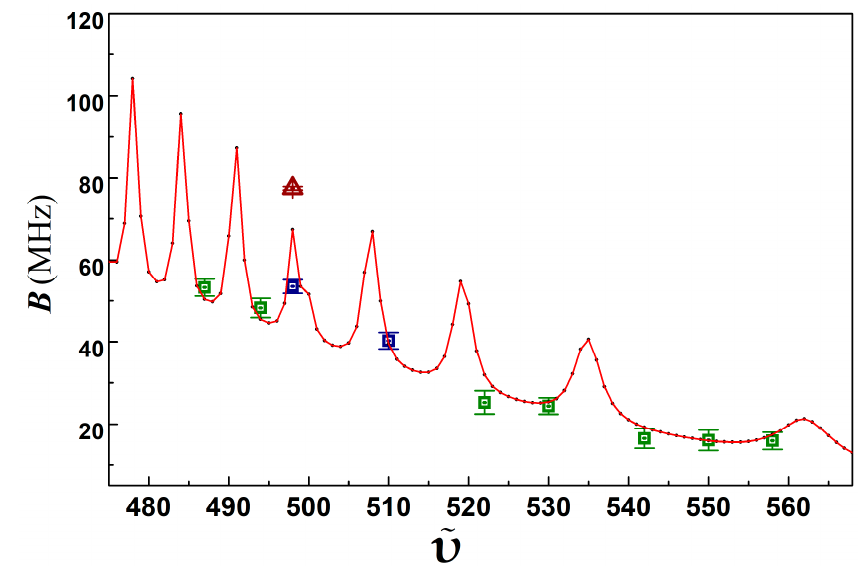
Figure 5. Rotational constants Bv of the rovibrational levels (˜ v ) in Cs 2 0 + u state below the dissociation limit 6S 1 / 2 + 6P 1 / 2 . Triangle is the value reported in Ref. [31], other newly observed values are in green squares. The blue squares for ˜ v = 498 and 510, which were observed previously, have also been measured and presented for comparison. The black dots are the theoretical rotational constants, computed in a two channel quantum mechanical simulation [31]. The solid red curve is the connection of the dots. The newly observed values are in good consistence with the theoretical curve.